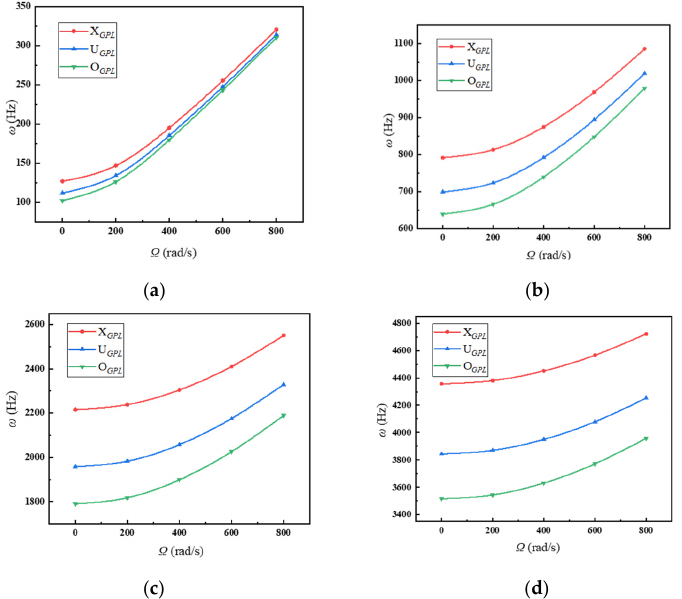
Figure 8. Variations of frequencies with rotating speed under different ratios of core layer thickness and surface layer thickness. ( a ) First frequency; ( b ) second frequency; ( c ) third frequency; ( d ) fourth frequency.